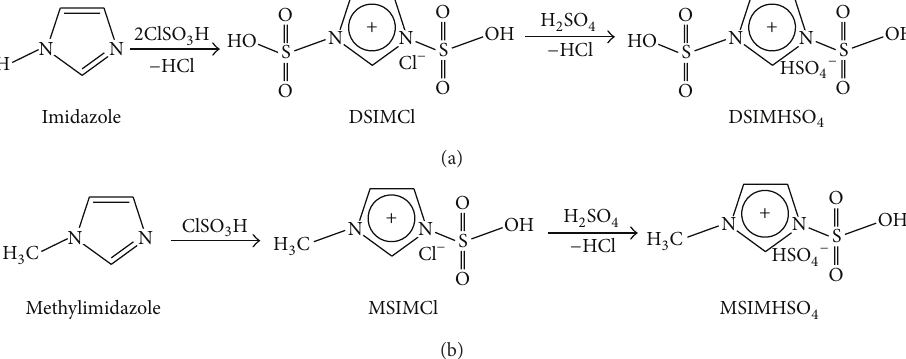
Figure 2: Synthesis of ILs via two-step scheme: (a) synthesis of DSIMHSO 4 by direct metathesis between DSIMCl and H 2 SO 4 ; (b) synthesis of MSIMHSO 4 by direct metathesis between MSIMCl and H 2 SO 4 .